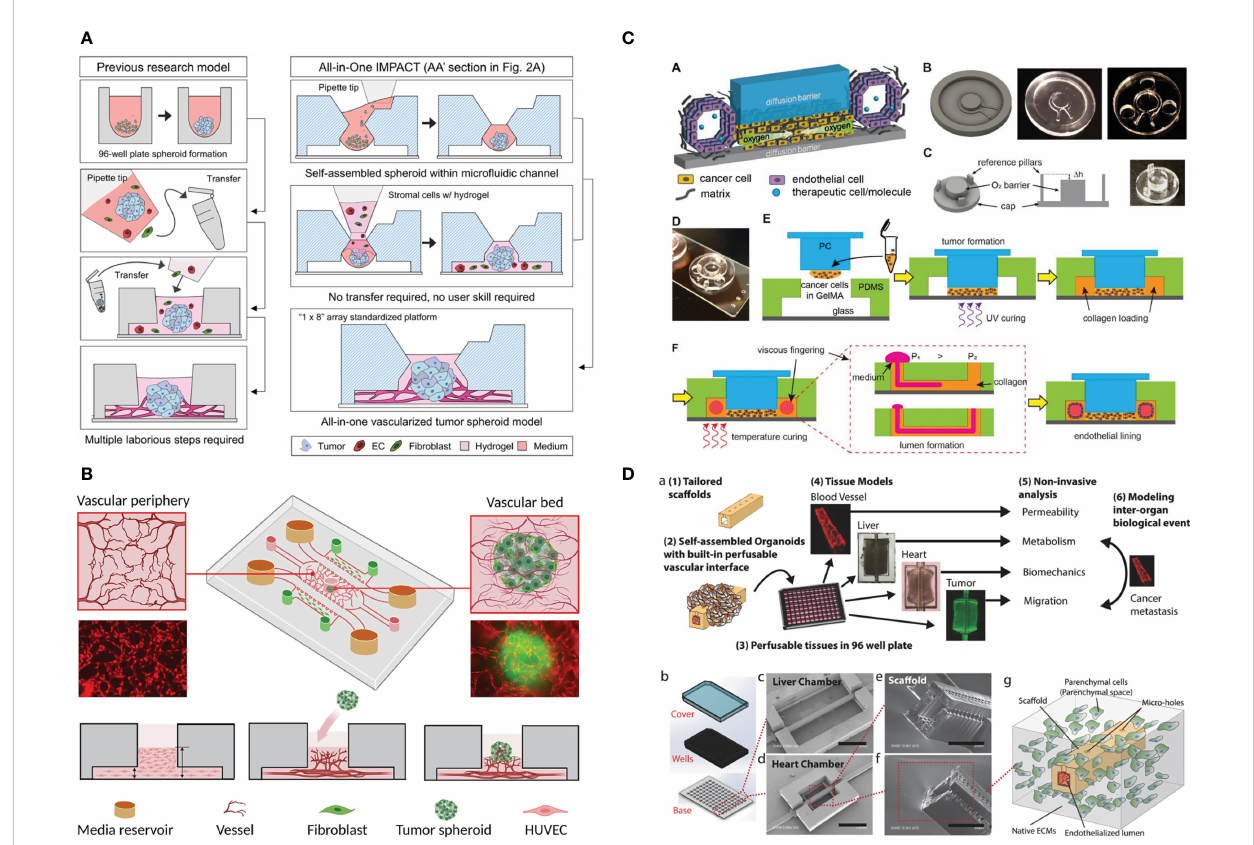
FIGURE 3 Example of the application of vascularized tumor-on-a-chip for therapeutics screening. (A) The all-in-one IMPACT device allows spheroid formation and vascularization on the same device, making it more user-friendly. Adapted with permission. Copyright 2022 Wiley Periodicals LLC. (B) The device design with a small hole on top of the device enabled spheroid introduction after microvascular network formation. Adapted with permission. Copyright 2022, American Chemical Society. (C) Device design allowing oxygen gradient generation with the gas-impermeable PC cap. Endothelial cells are seeded on lumen created by viscous fi nger patterning. Adapted under the terms of the Creative Commons Attribution License (CC BY). Copyright 2021 Ando et al. (D) The multi-organ InVADE platform that enables drug sensitivity and other organs ’ toxicity test in one chip.